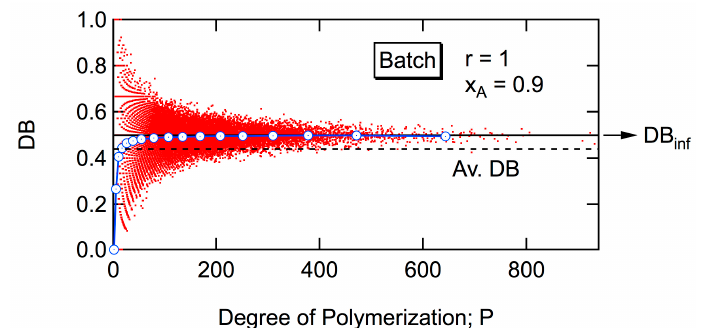
Figure 3. Relationship between degree of branching (DB) and P for batch polymerization with r = 1 at the conversion level of A, x A = 0.9. Similar figures can be found in the earlier publications for a batch reactor [6,7] and for a CSTR [8,9].